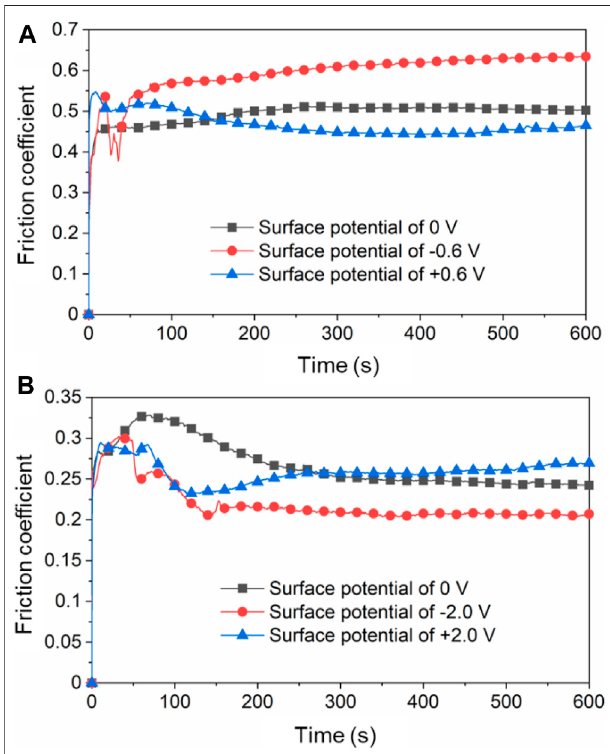
FIGURE 9 | Friction coef fi cients of Cu plate vs. ZrO 2 ball over time in (A) H 2 O as lubricant and (B) PC as lubricant under different surface potentials of Cu